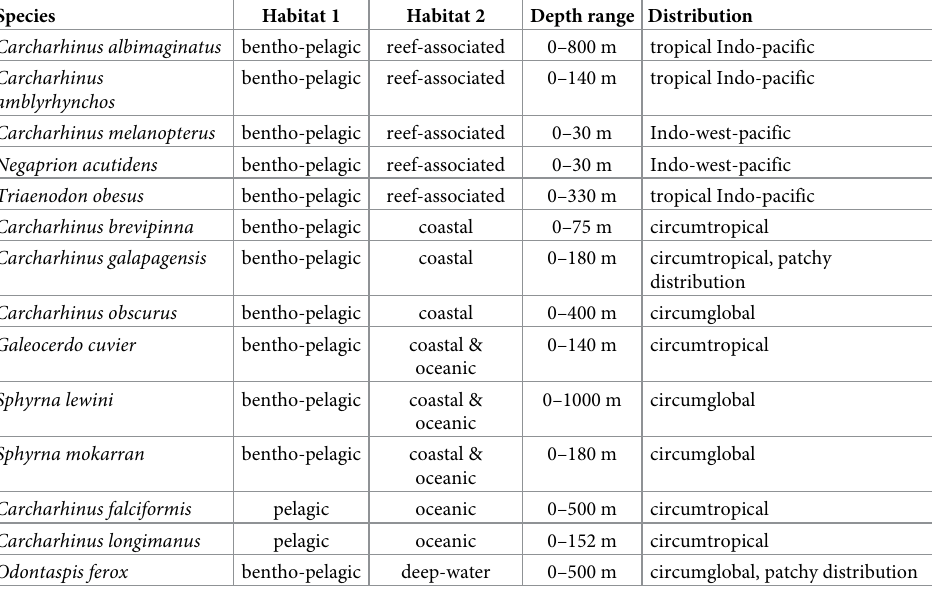
Table 4. Habitats and geographical distributions of the shark species recorded from Europa